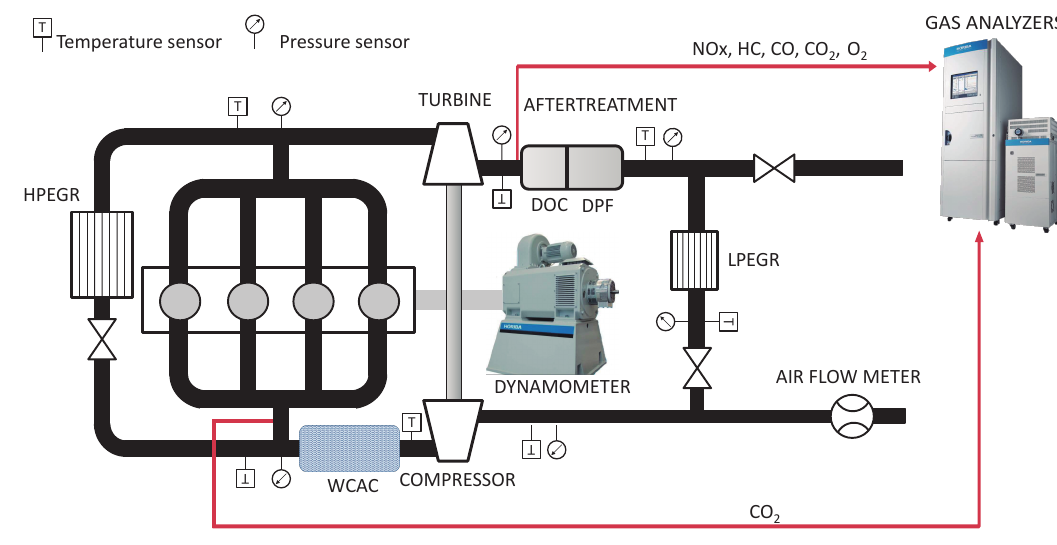
Figure 2. Engine layout indicating the pressure, temperature and exhaust gases measurement